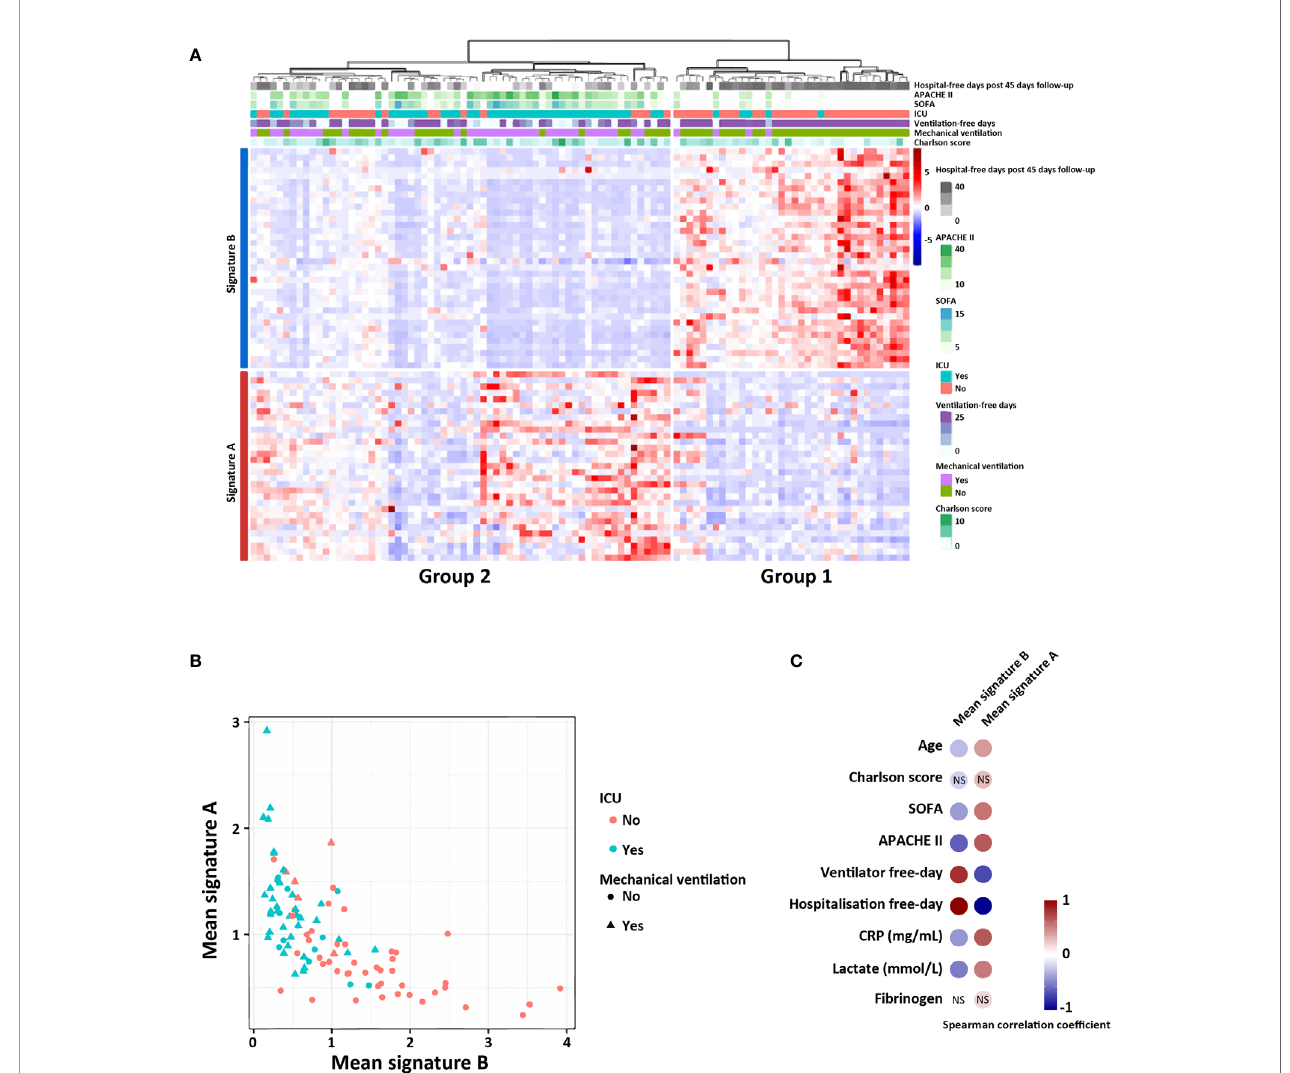
FIGURE 3 | Signatures A and B identify two groups of patients in a public COVID-19 patient cohort (RNAseq data). (A) Heatmap showing relative expression of the gene signature and hierarchical clustering of COVID-19 patients with clinical and biological annotation. (B) Mean expression of the signatures A and B according to type of service hospitalization (ICU or not) and the need of mechanical ventilation (yes or not). (C) Signi fi cant correlation between the mean expression of — signatures A and B with the different clinical scores and biological values. Correlations were determined with the spearman correlation coef fi cient. NS, not signi fi